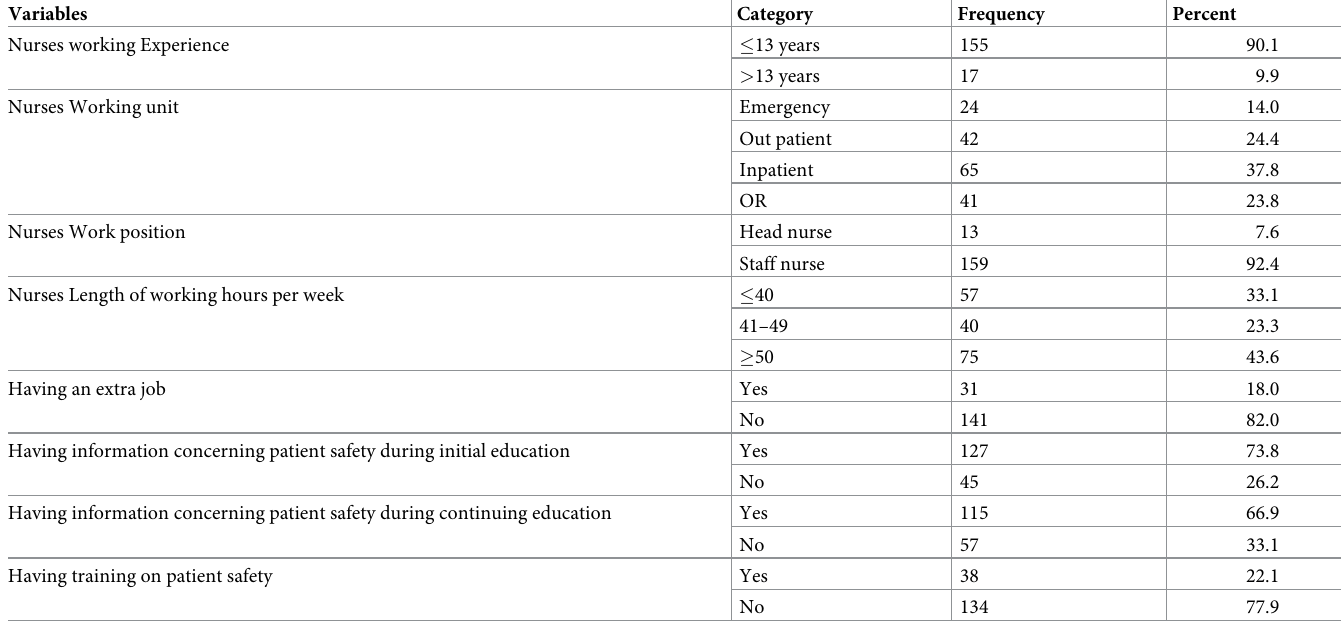
Table 2. Personal related characteristics of nurses’ working at Asella Referral and Teaching Hospital, Asella, Ethiopia, 2021, [n = 172].